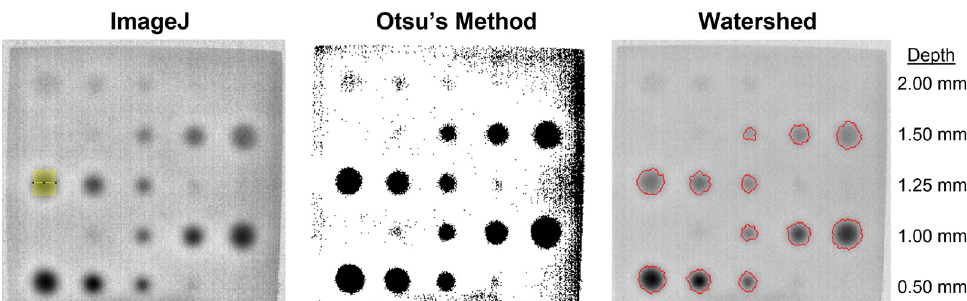
Figure 10. Measurement procedure performed using the ImageJ software on the TSR first derivative image after histogram equalization (CLAHE), in comparison with the Otsu’s method and the watershed segmented